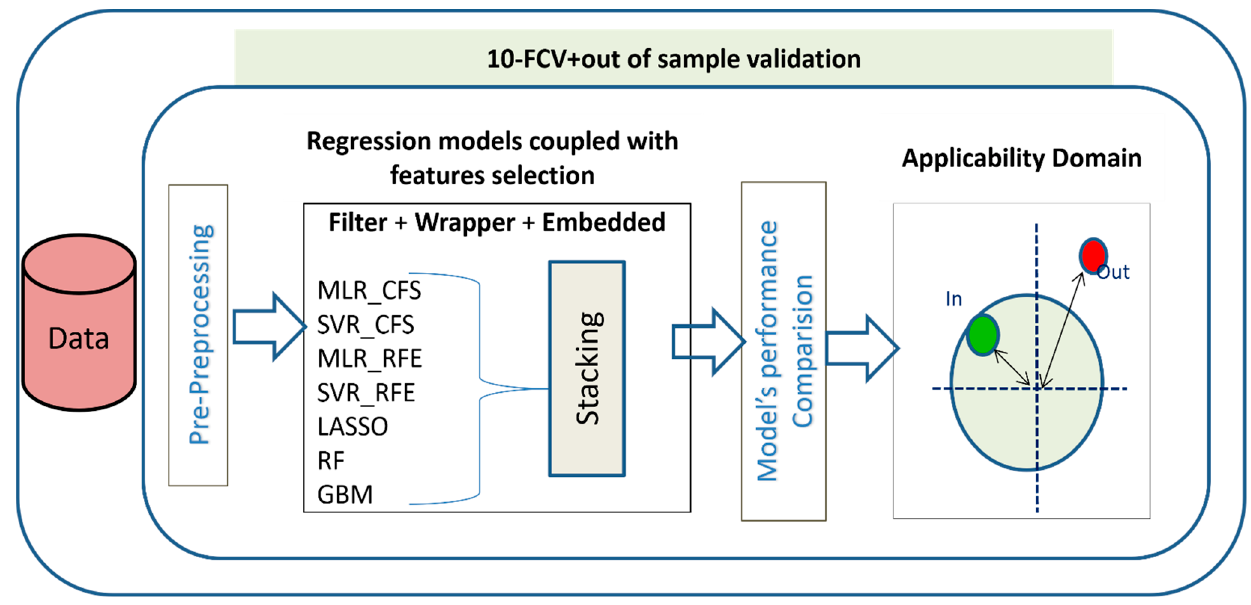
Figure 1. Workflow describing the steps of QSRR